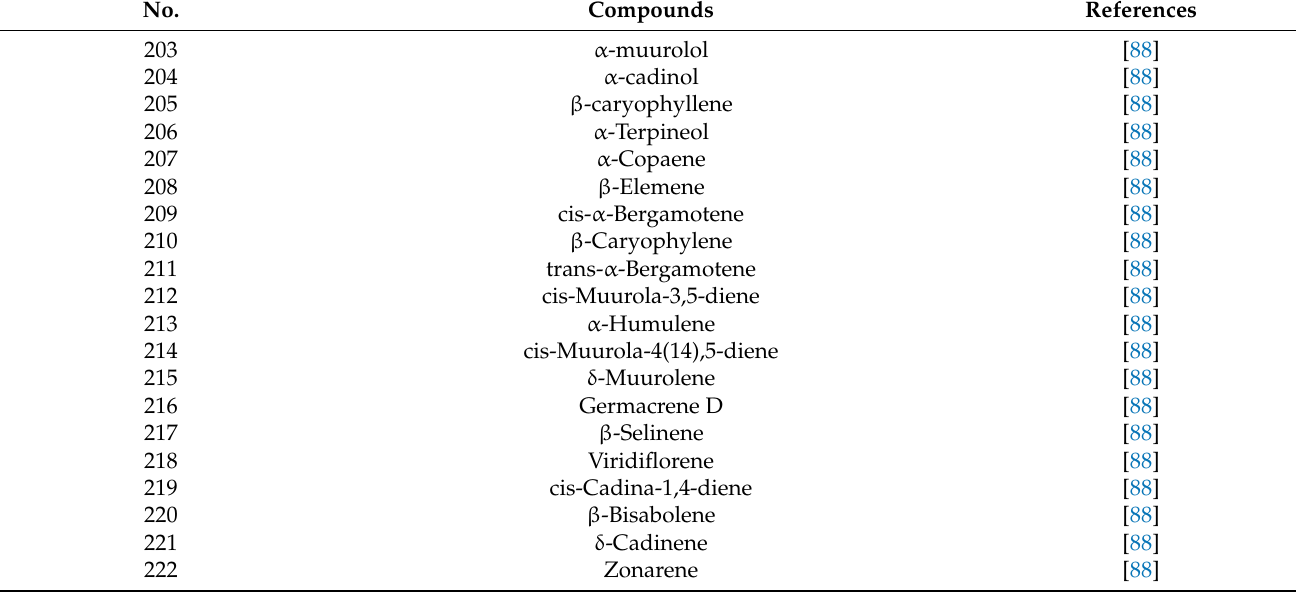
Table 3. Other novel terpenoids isolated from Kadsura longipenduculata .